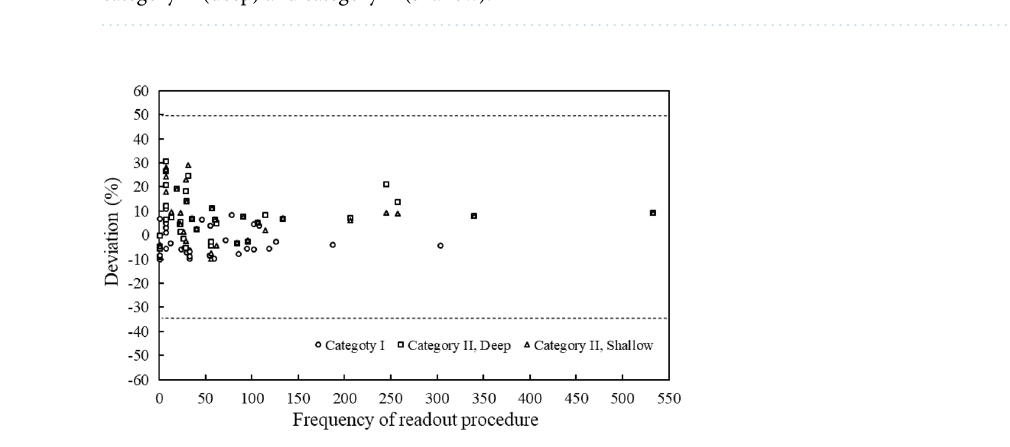
Figure 4. The badge dose deviations corresponded to the frequency of readout procedure, which were showed in categories I, II (deep) and II